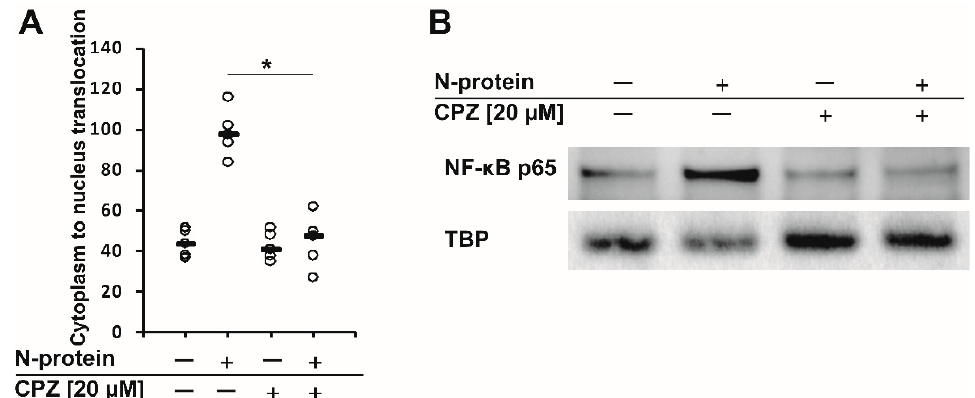
Figure 5. Chlorpromazine inhibits the translocation of the NF- κ B transcription factor from the cytoplasm to the nucleus mediated by the SARS-CoV-2 nucleocapsid. ( A ) Human monocytes were pretreated with chlorpromazine (20 µ M) for 3 h and then stimulated with 1 µ g/mL SARS-CoV-2 nucleocapsid for 1 h. Cells were then stained with NF- κ B p65 (D14E12) Alexa Fluor 488 conjugated antibody, and fluorescence was measured using the Cellomics ArrayScan HCS Reader. Data are shown as dot plots with median values from five independent donors (n = 5). Asterisks indicate a statistically significant difference at p < 0.05. Statistical analysis was performed using Friedman Repeated Measures ANOVA on Ranks followed by Student-Newman–Keuls post hoc test. ( B ) Western blotting results showing an increased level of NF- κ B p65 in nuclear fractions after treatment with 1 µ g/mL SARS-CoV-2 nucleocapsid and inhibition of translocation into the nucleus by chlorpromazine (20 µ M, 3 h). TBP was used as a loading control.